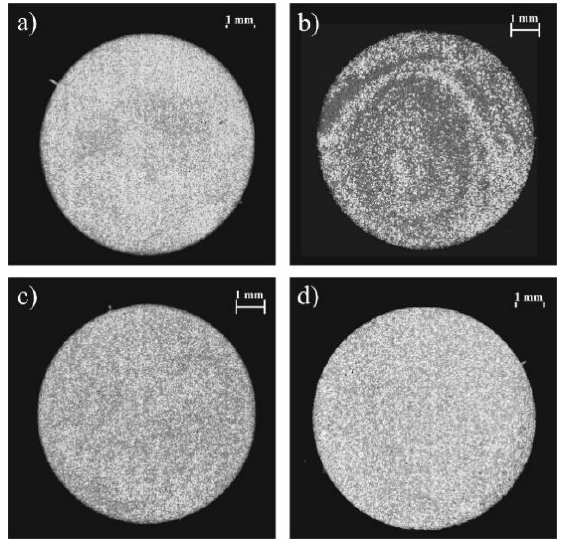
Figure 4. Macrographs of hot compacts mixed by ( a ) magnetic mixing (MM2); ( b ) ultrasonic mixing (UM2); ( c ) ball milling with a ball-to-powder ratio of 20:1 (BM2); ( d ) ball milling with a ball-to-powder ratio of 80:1